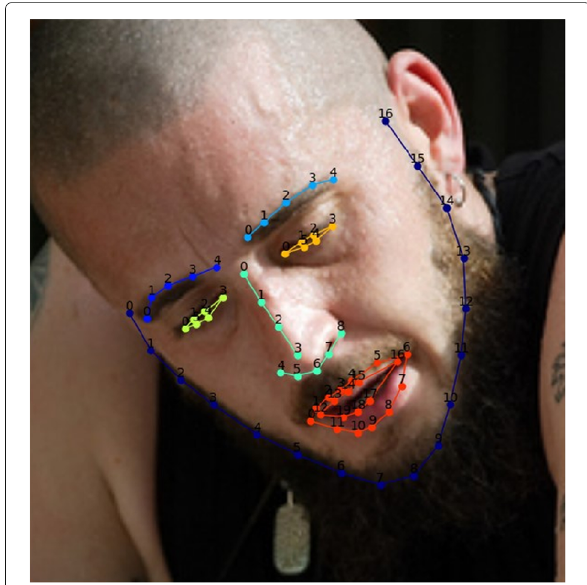
Fig. 1 Example annotated image. Example training image provided for the second facial landmark localisation competition held in conjunction with International Conference on Computer Vision and Pattern Recognition (CVPR) 2017